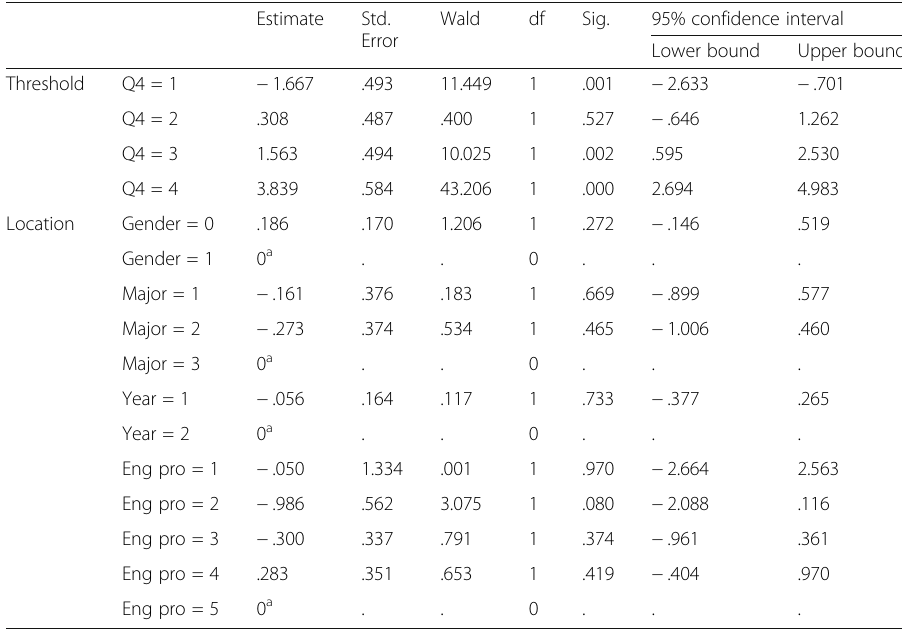
Table 9 Factors influencing students ’ English learning motivation Estimate Std. Wald df Sig. 95% confidence interval Error Lower bound Upper bound